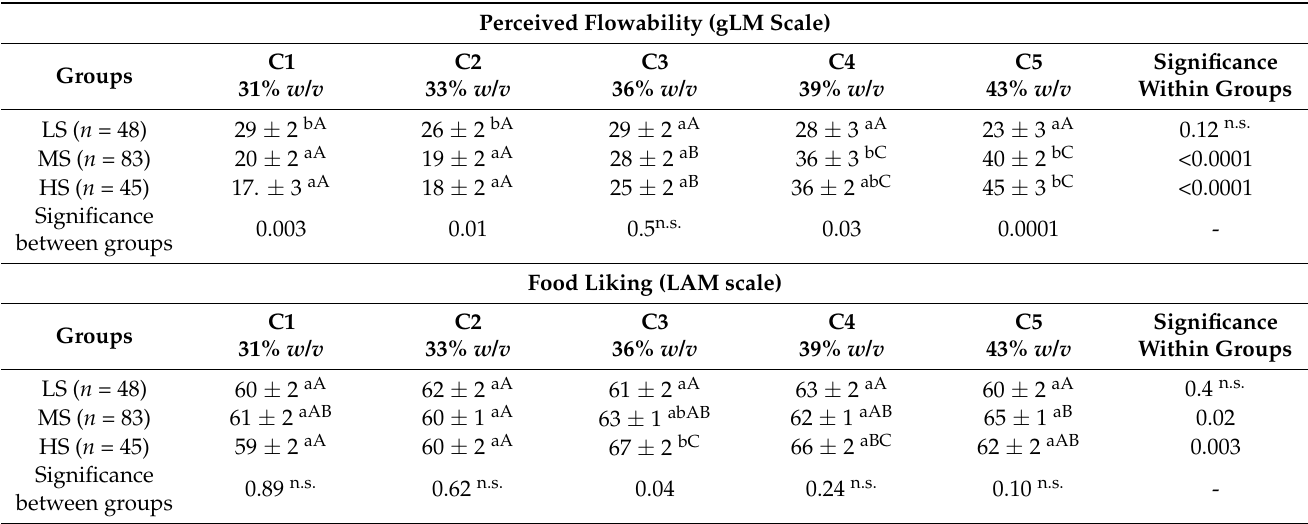
Table 4. Perceived flowability and food liking scores (mean value ± standard error) given by different groups: high- sensitivity (HS) group, low-sensitivity (LS) group and moderate-sensitivity (MS)